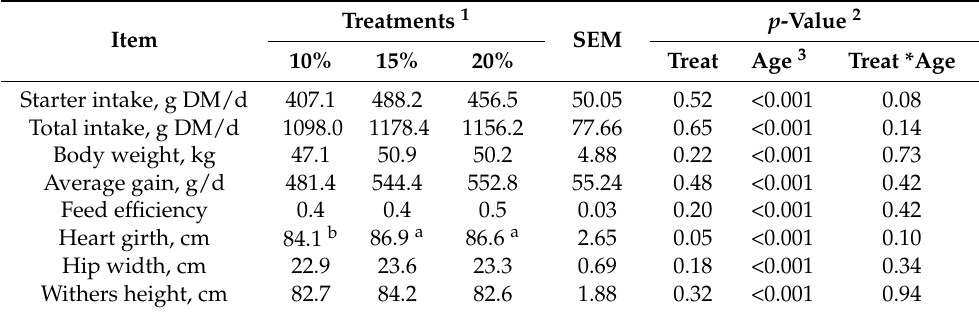
Table 2. Growth and intake of dairy calves fed different volumes of colostrum at birth. Item